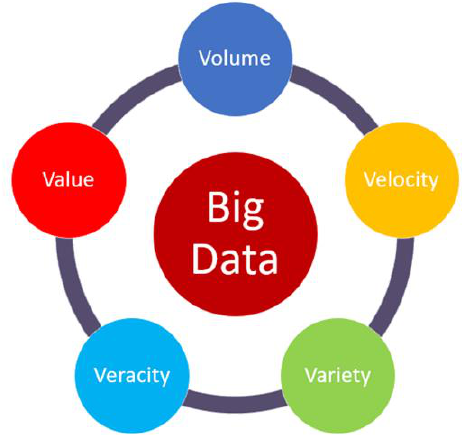
Figure 4. Five Vs of big data.